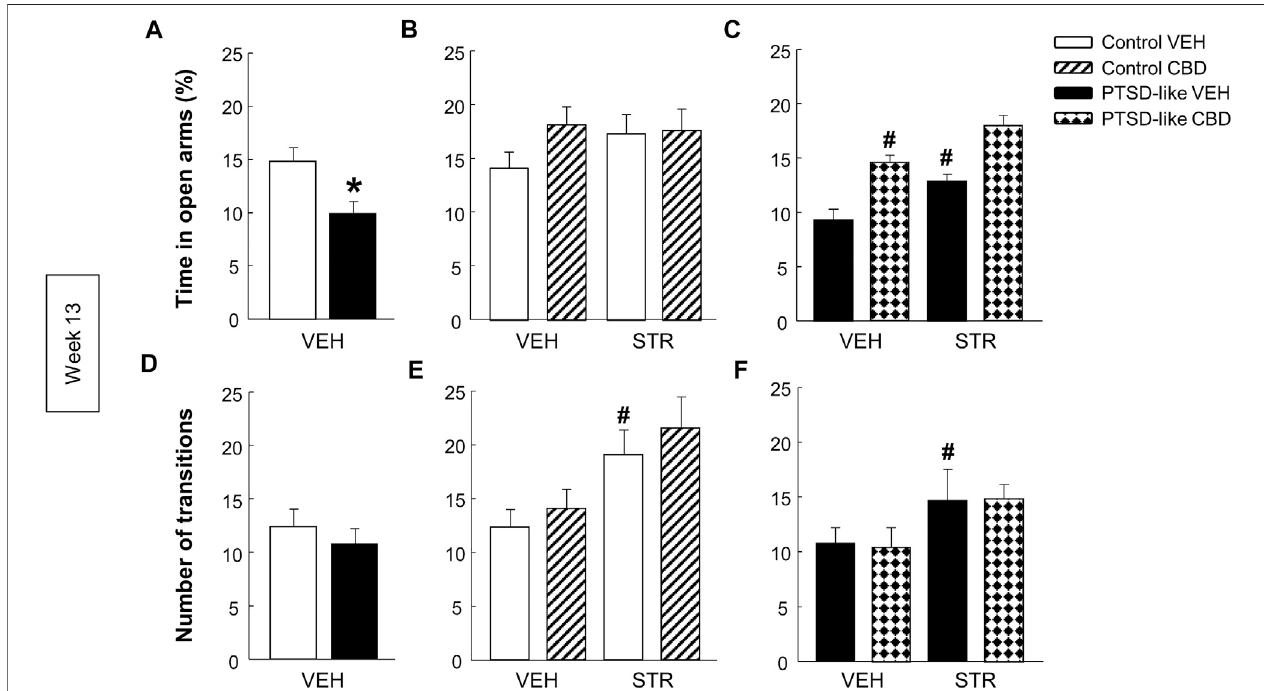
FIGURE 7 | Evaluation of anxiety-like behavior by the elevated plus maze (EPM) paradigm at week 13. Comparative analysis between control and PTSD-like VEH- treatedmiceofthetimespentintheopenarms(s) (A) andthenumberoftransitions (D) .EffectsofCBD(20 mg/kg,i.p.)and/orSTR(10 mg/kg,p.o.)administration,orits corresponding VEH, on the time spent in the open arms (s) (B,C) and the number of transitions (E,F) of control and PTSD-like mice. Columns represent the mean and verticallines ± SEM.*,Values fromPTSD-likeVEH-treatedmicethataresigni fi cantlydifferentfrom controlVEH-treated mice(Student ’ s t -test, p < 0.001).#,Values fromCBD-orSTR-treatedgroupsthataresigni fi cantlydifferentfromVEH-treatedmice(Two-wayANOVA, p < 0.001).and,ValuesfromCBDplusSTR-treatedmicethat aresigni fi cantlydifferentfromCBD-andSTR-treatedmice(Two-wayANOVA, p < 0.001).MiceexposedtothePTSD-likemodel:N(VEH) (cid:2) 10,N(CBD) (cid:2) 10,N(STR) (cid:2) 9, N(CBD plus STR) (cid:2) 10; control mice: N(VEH) (cid:2) 10, N(CBD) (cid:2) 9, N(STR) (cid:2) 9, N(CBD plus STR) (cid:2) 10.